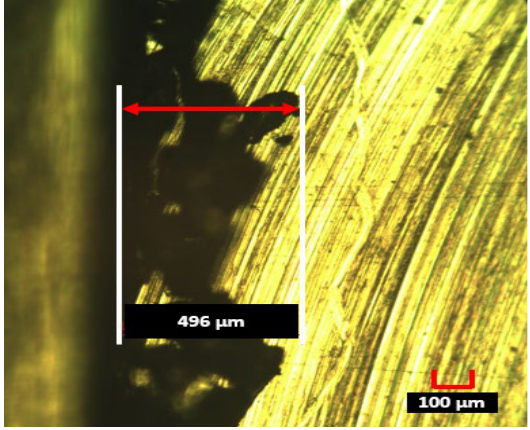
Figure 7. Maximum burr width noted on down-milling side of the workpiece.